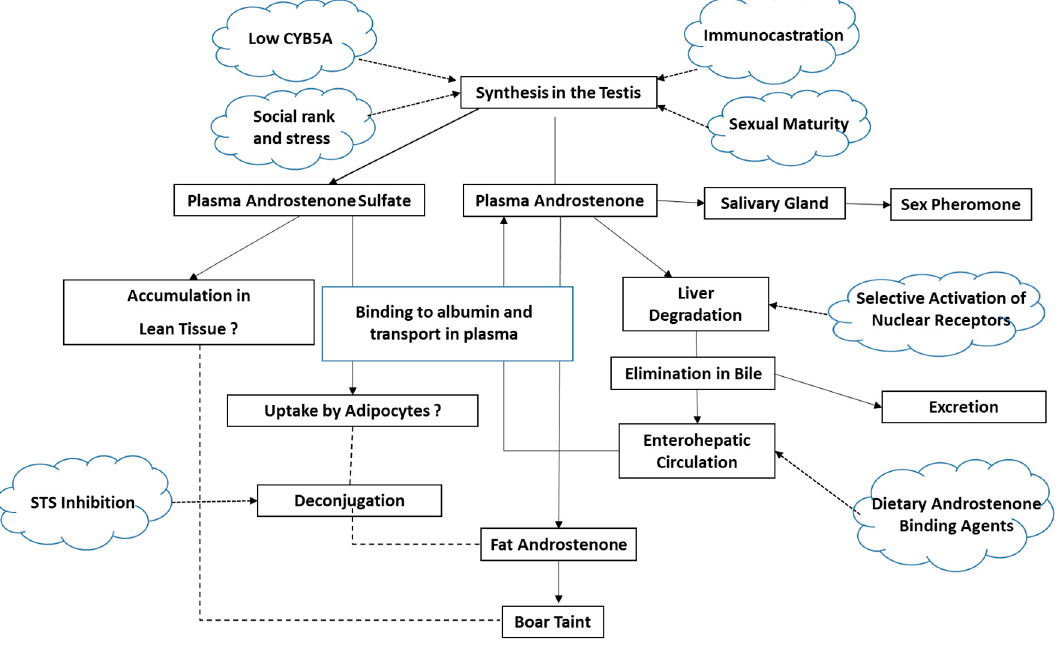
Figure 1. Flow chart of androstenone synthesis, metabolism and transport and factors affecting boar taint.